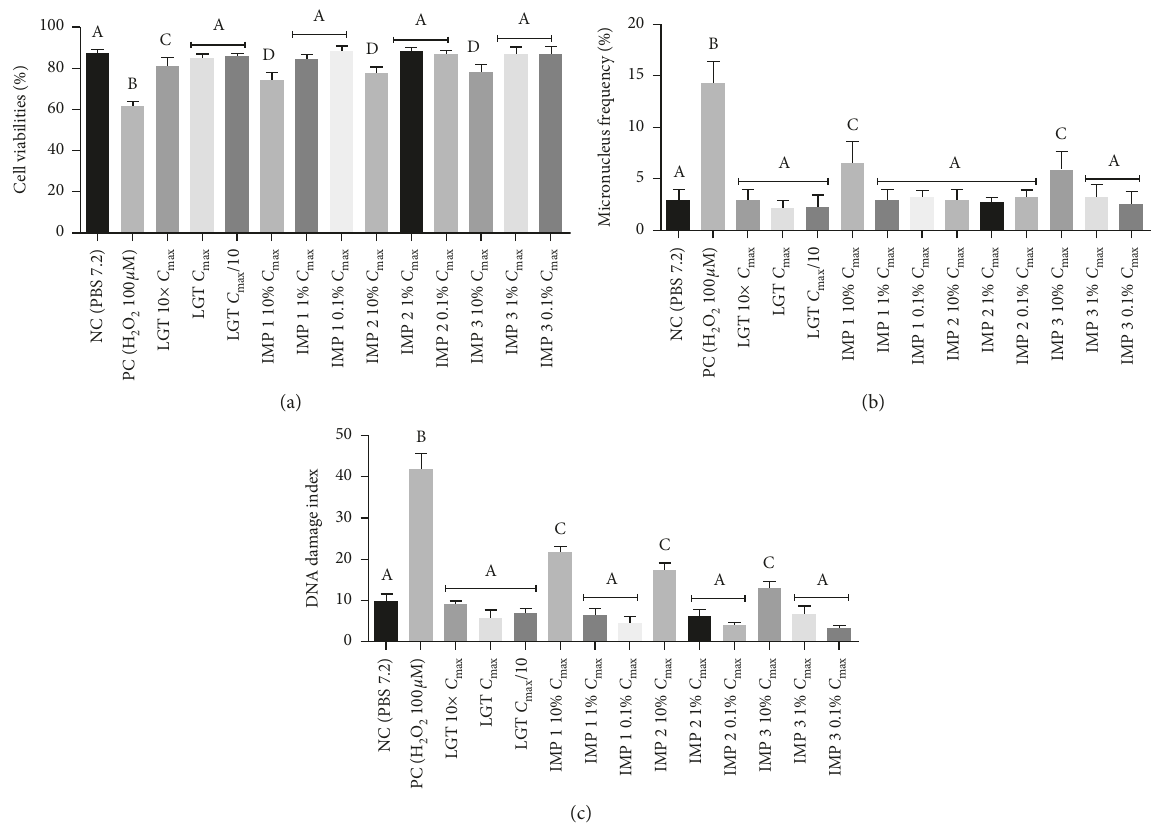
Figure 4: Results of the biological safety studies of the LGTdrug and synthetic impurities in different concentrations. (a) Cellular viability; (b) micronucleus frequency; (c) DNA damage. NC: negative control; PC: positive control; LGT: linagliptin; IMP 1: impurity 1; IMP 2: impurity 2; IMP 3: impurity 3; 10 × C max : ten times greater than the maximum concentration of LGT; C max : maximum concentration of LGT; C max /PP: ten times lower than the maximum concentration of LGT. ∗ Different letters differ